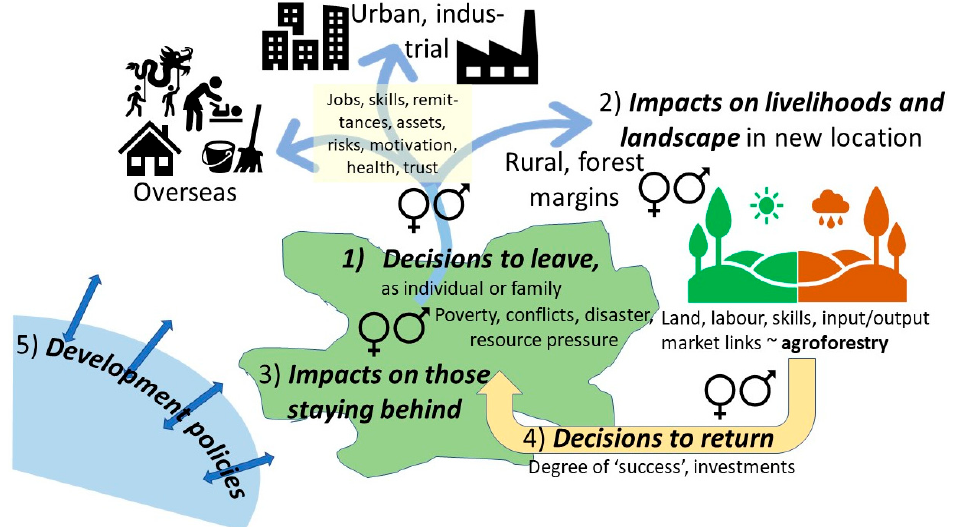
Figure 1. Gender-specific aspects before, during, and after (circular) migration decisions concerning land use in the area of origin.